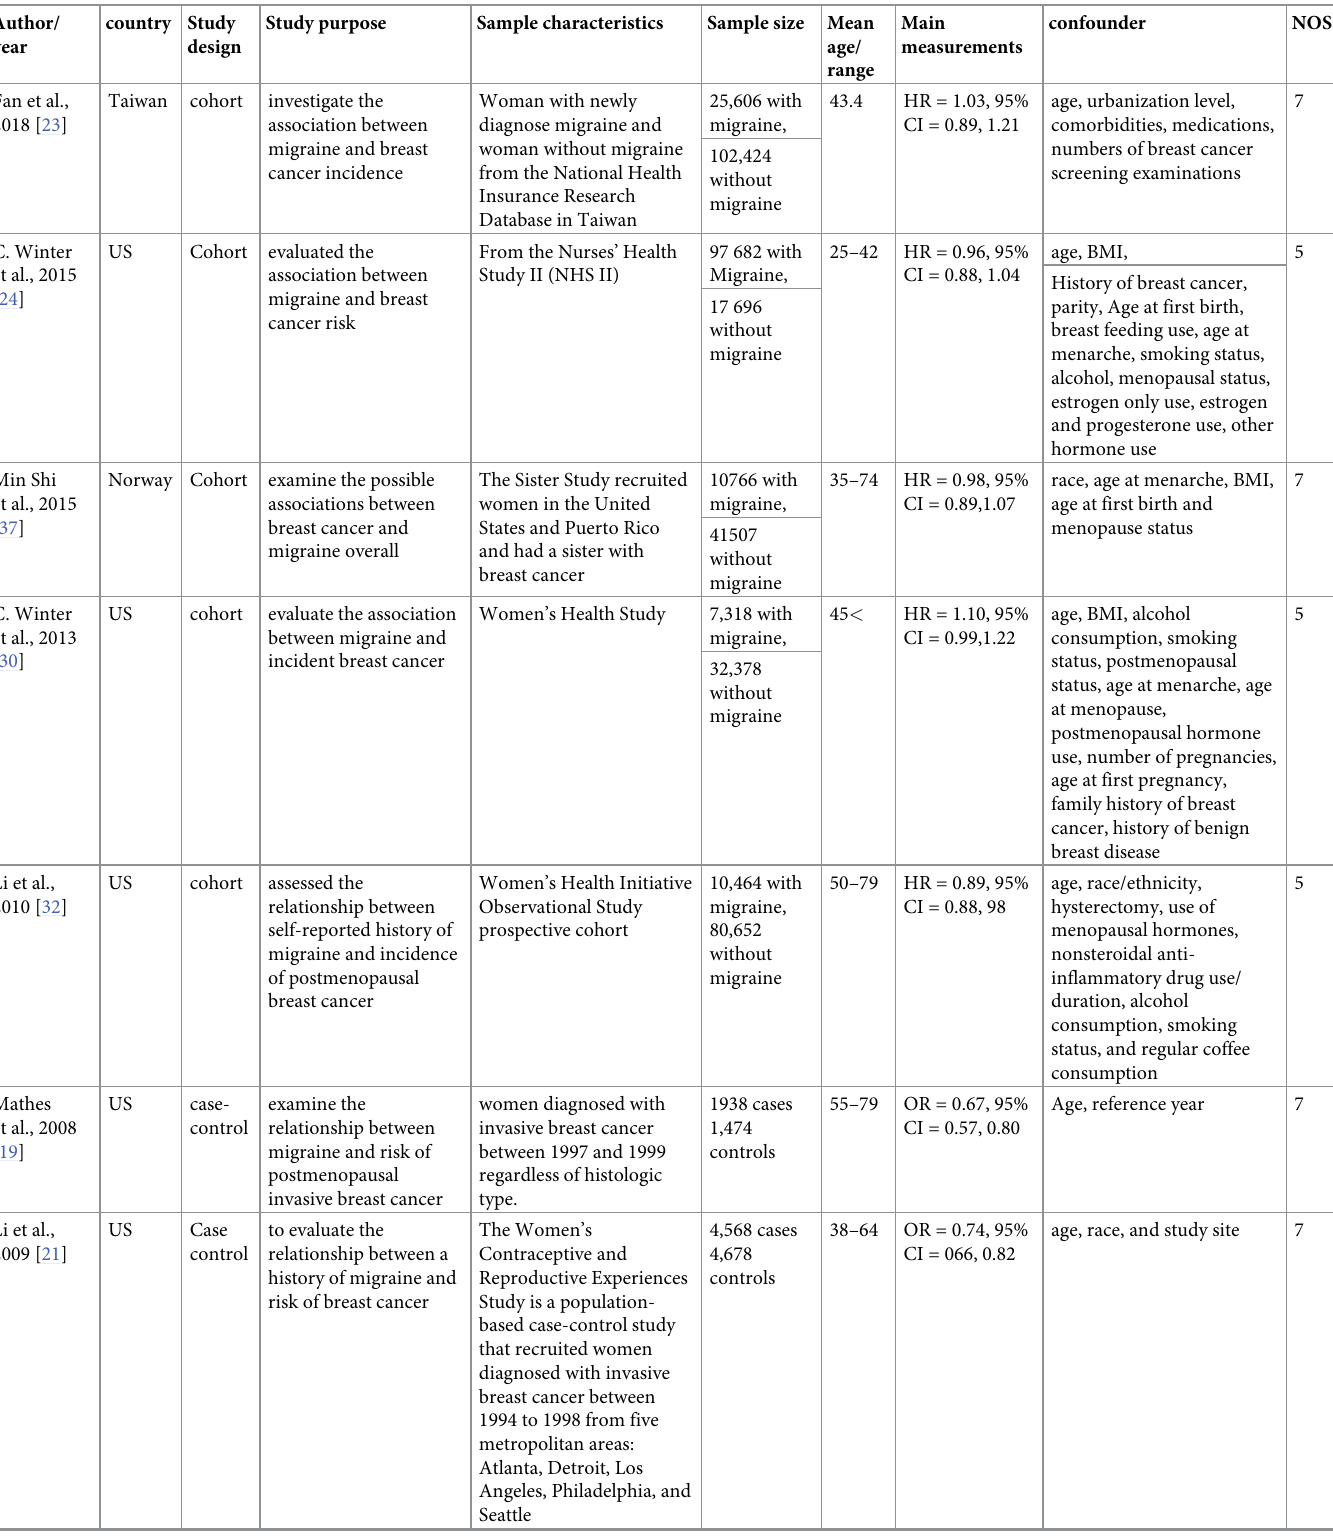
Table 1. Characteristics of included studies in the